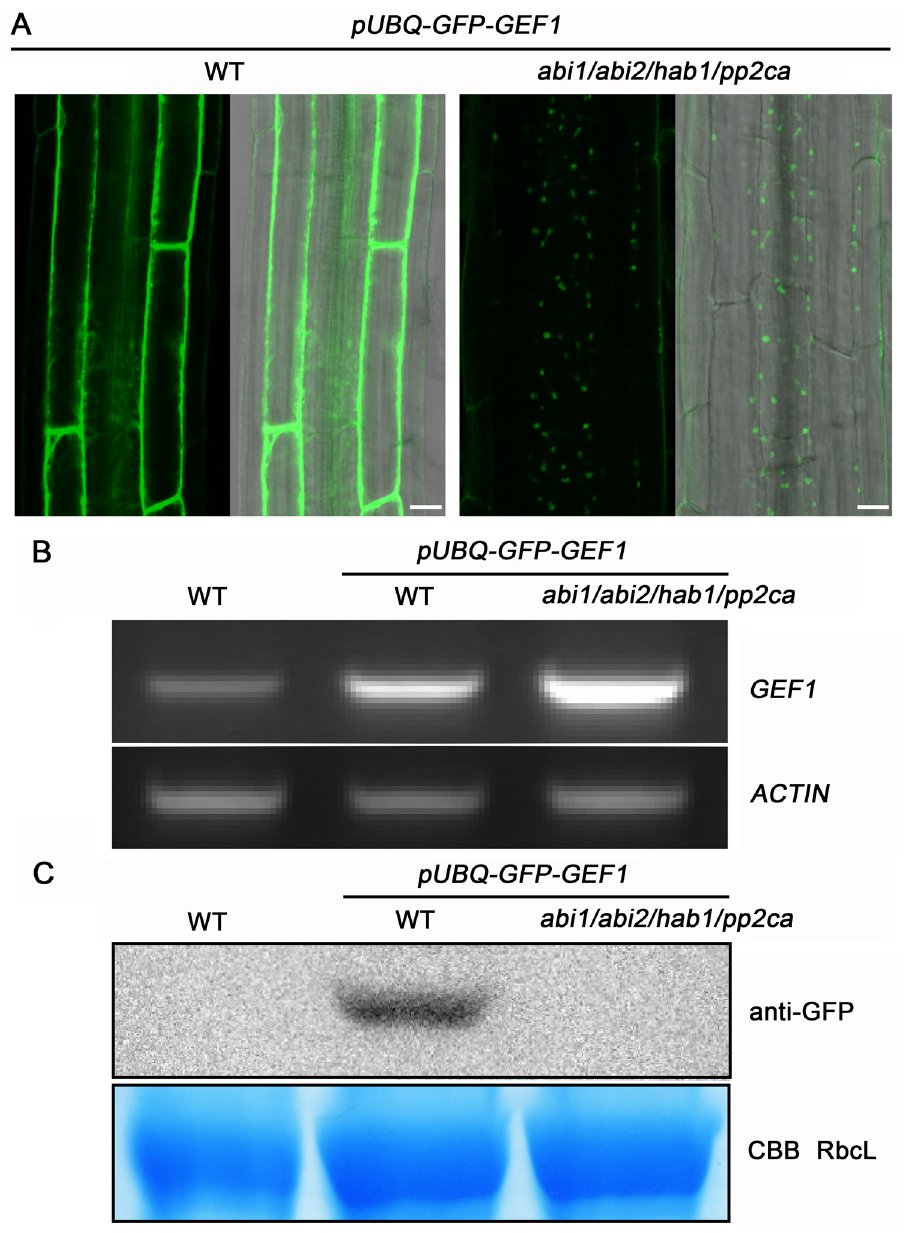
Fig 5. GFP-GEF1 is constitutively degraded in abi1/abi2/hab1/pp2ca quadruple mutant background. (A) Subcellular localization of GFP-GEF1 in root epidermal cells of wild type (left) and abi1/abi2/hab1/pp2ca background (right) in the absence of exogenous ABA. Confocal images were acquired and are shown with the same parameters except master gain: 700 (WT), 980 ( abi1abi2hab1pp2ca ). Scale bars: 10 μ m. The depicted imaging experiments were repeated at least three times (see Methods). (B) RT-PCR analyses of GEF1 transcripts in wild-type plants and GFP-GEF1 overexpression lines in wild-type and abi1/abi2/hab1/ pp2ca mutant background. RT-PCR for ACTIN2 transcripts was used as loading control. (C) Western blot analyses of GFP-GEF1 protein levels with anti-GFP antibody in wild-type plants and GFP-GEF1 overexpression lines in wild-type and abi1/abi2/hab1/pp2ca mutant background. Coomassie blue (CBB) stain of SDS-PAGE gel was used as a loading control. RbcL, RubisCO large subunit. Roots of 10-day-old seedlings grown on half MS medium were collected to extract total RNA (B) and protein